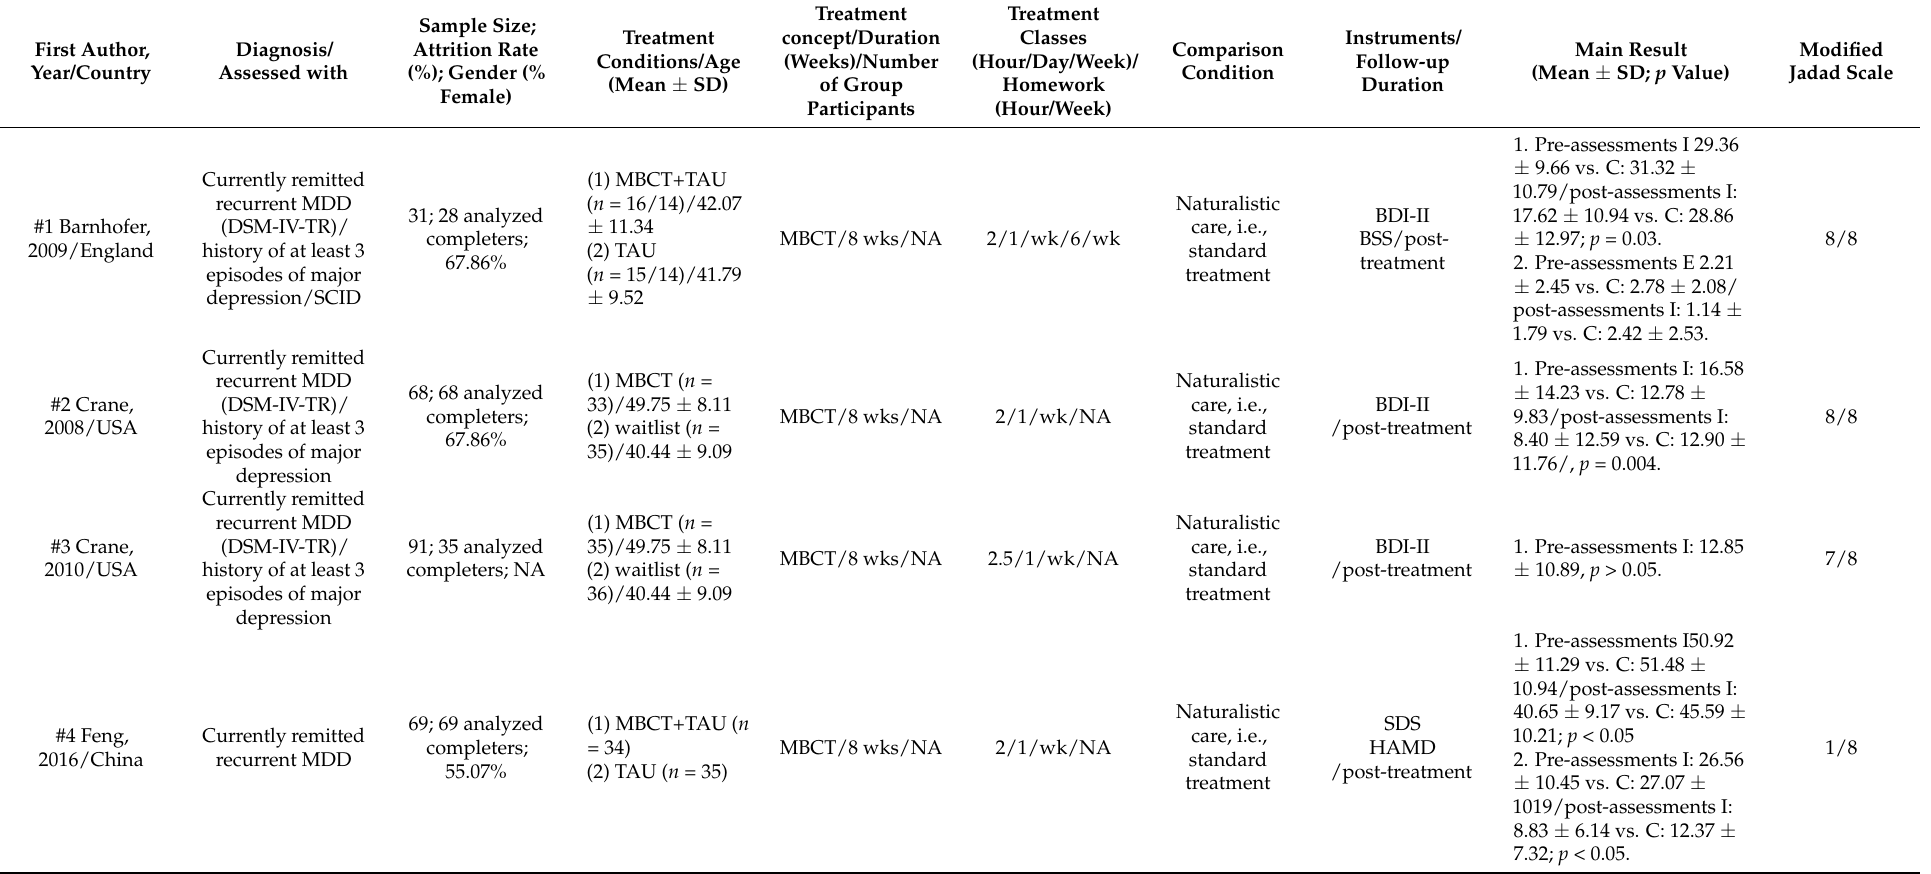
Table 1. Characteristics of included